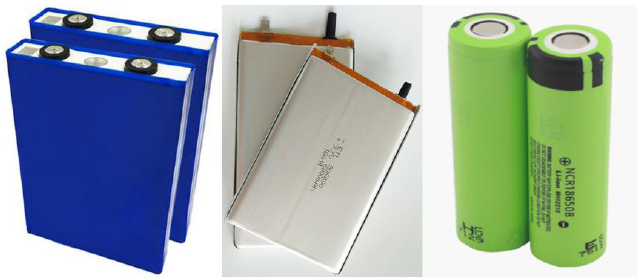
Figure 1. A prismatic battery, pouch battery and cylindrical battery (from left to right).